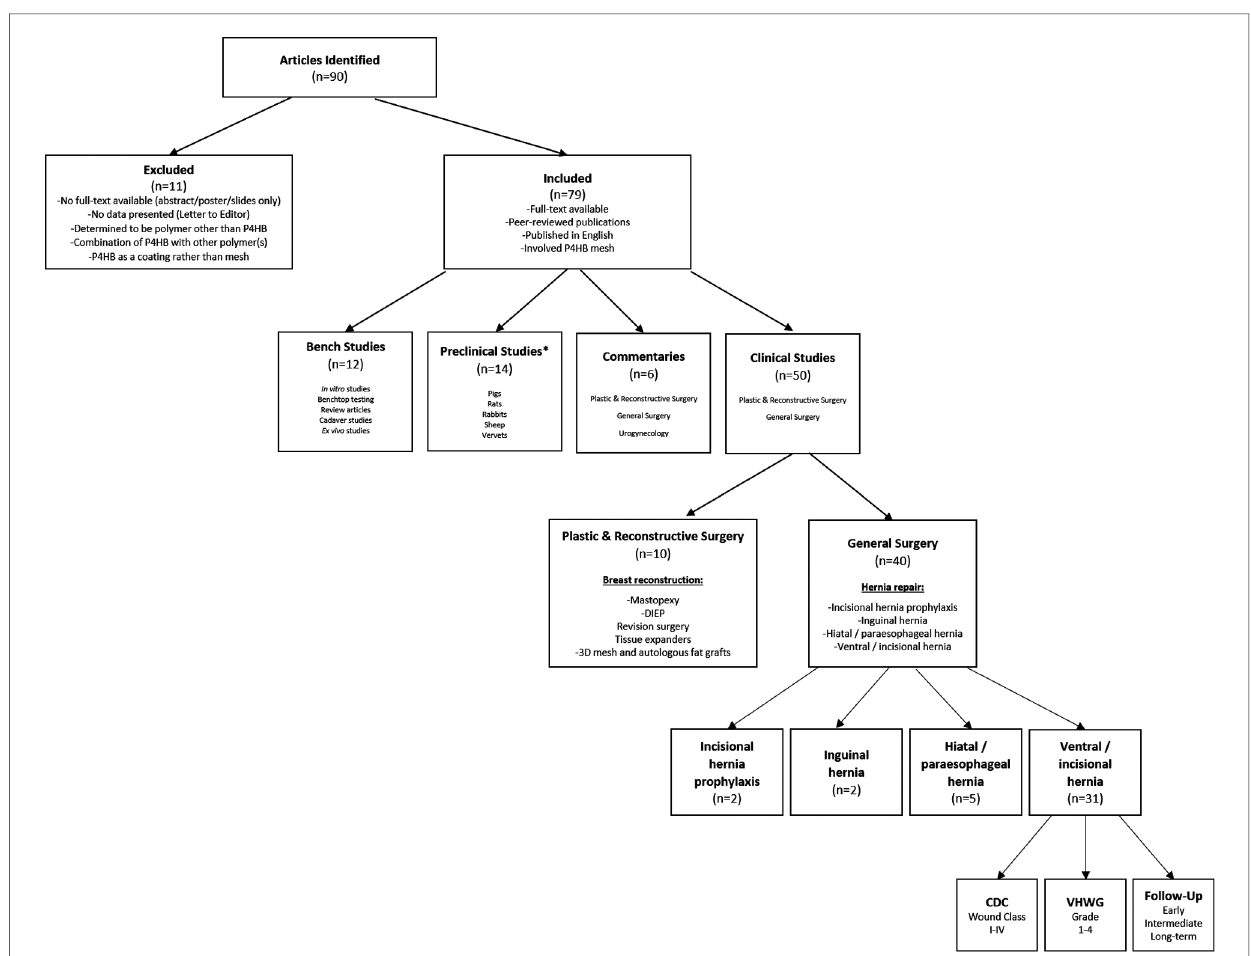
FIGURE 2 Flowchart depicting depth and breadth of studies that have evaluated P4HB mesh. * n =3 articles with both Bench and Preclinical components. DIEP, deep inferior epigastric perforator fl